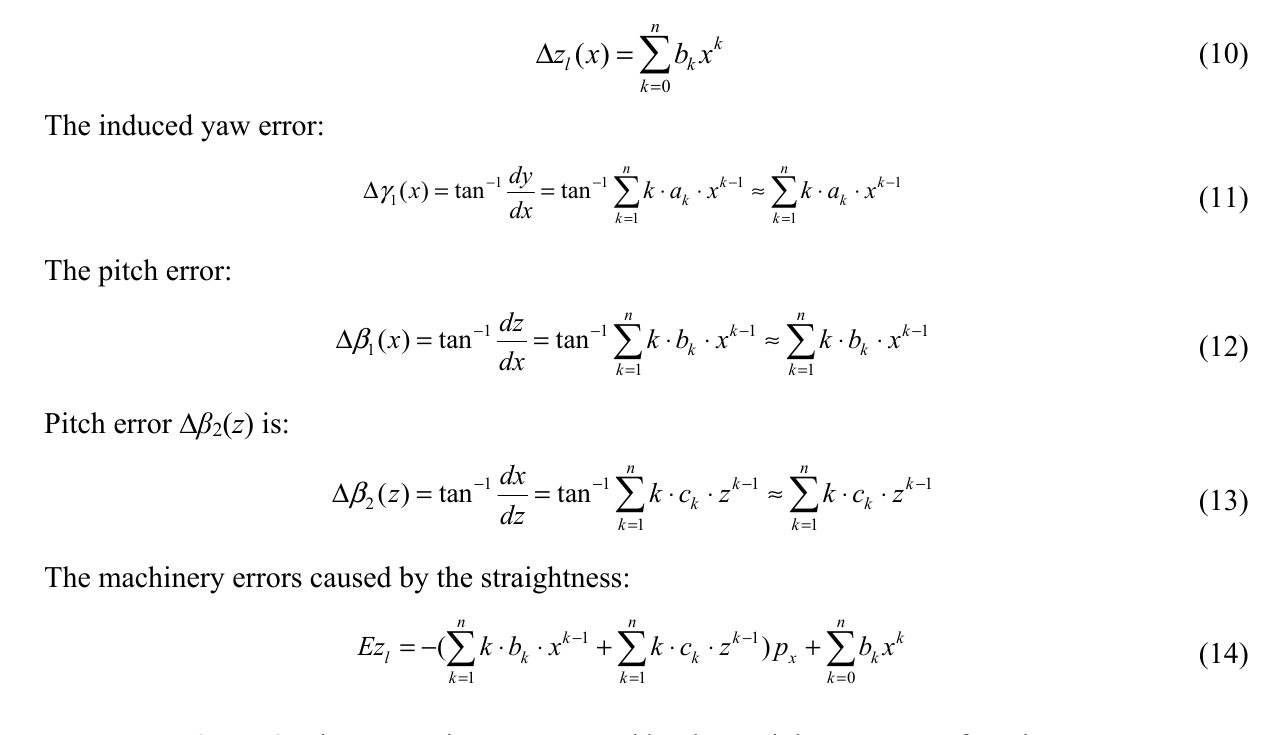
Figure 2. The processing error caused by the straightness error of